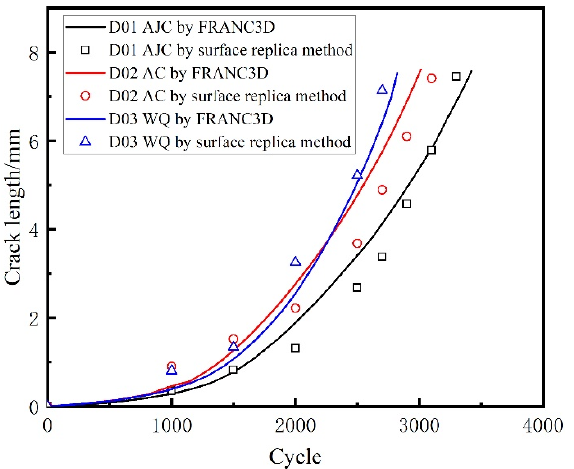
Figure 26. Comparison of crack length between the replica method and FRANC3D simulation at 47,500 rpm.